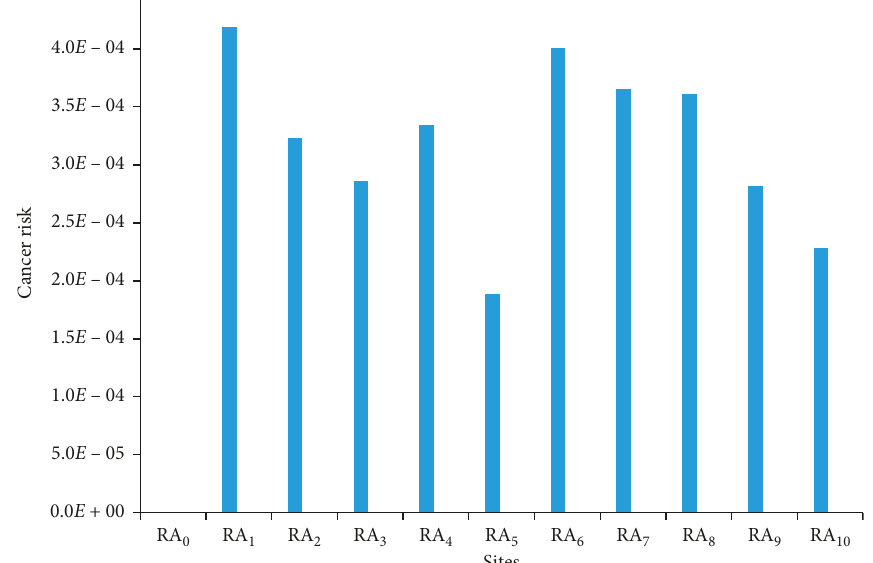
Figure 3: Cancer risks (CR) at the monitoring sites (CR at RA0 was not calculated because CH